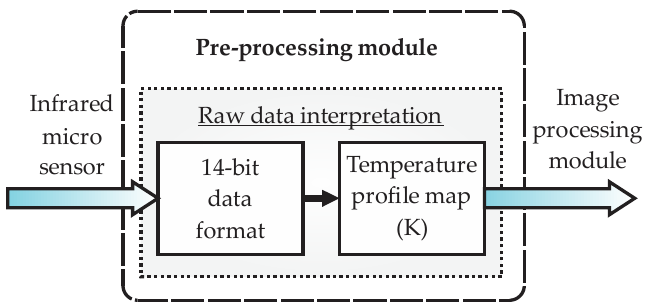
Figure 3. Block diagram of the preprocessing module in the smart sensor.